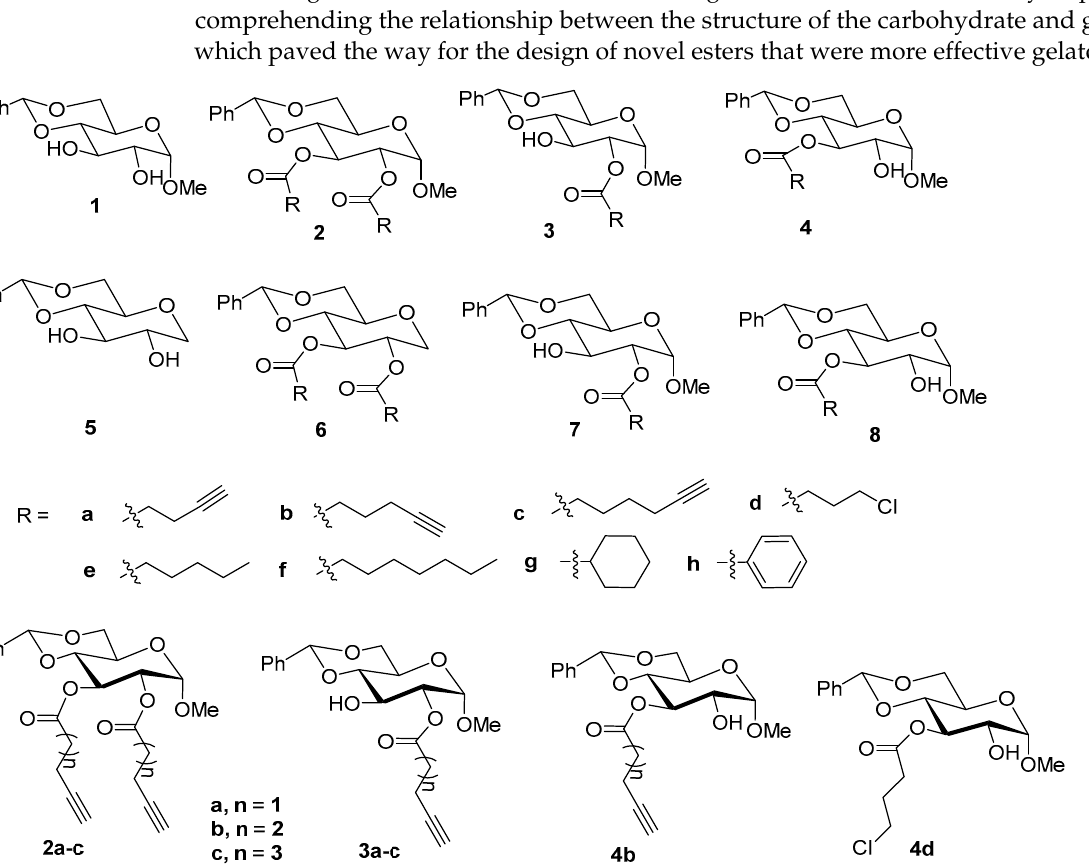
Figure 2. General structures of several classes of glucose ester derivatives as LMWGs [31,32], n represents the number of repeating CH 2 .